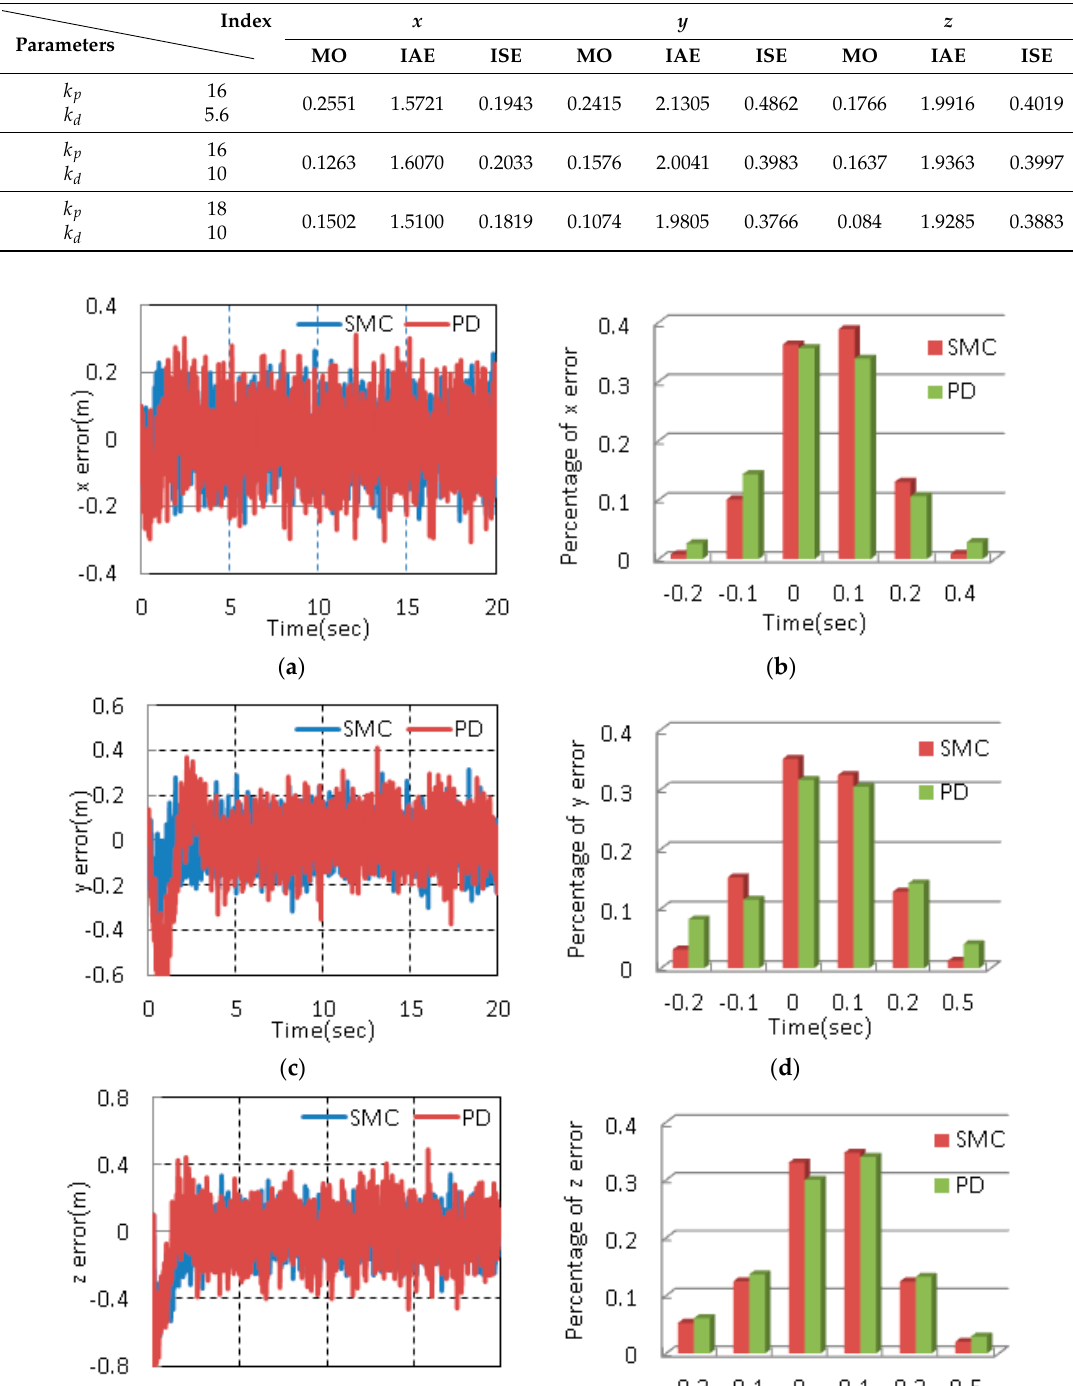
Table 6. Comparison of experiment results under three sets of PD parameters.